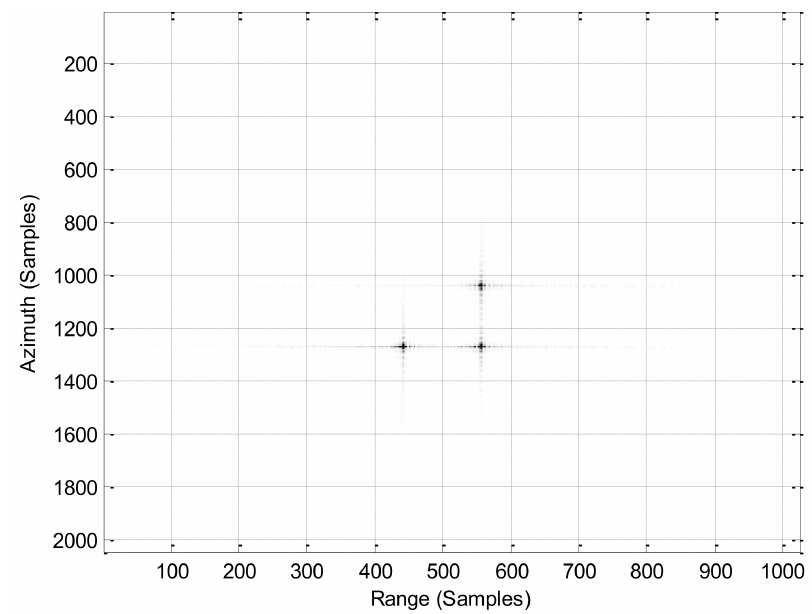
Figure 14. Azimuth-compressed SAR image by MATLAB.